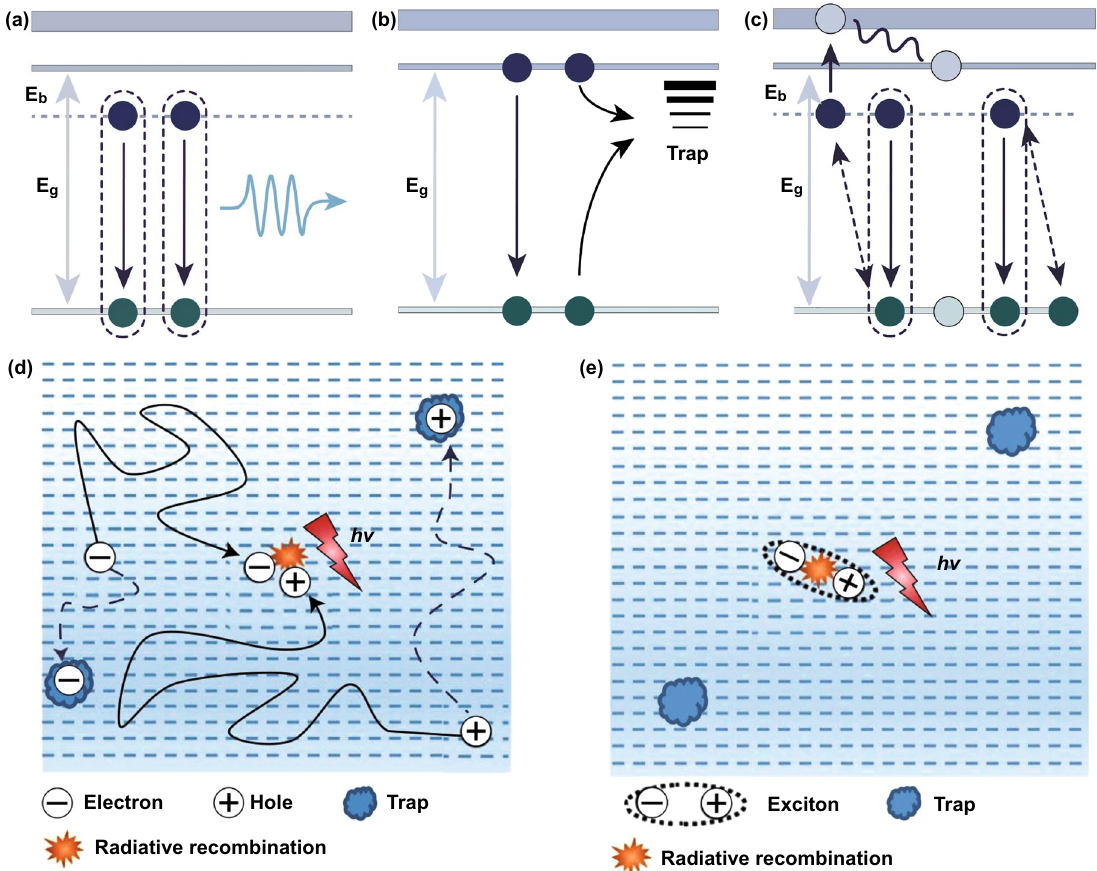
Fig. 3 a Exciton recombination. b Trap-assistant recombination. c Auger recombination. Copyright 2021 Springer Nature [72]. A schematic illustration of charge-carrier recombination d in 3D perovskites and e in 2D perovskites. Copyright 2020 Springer Nature